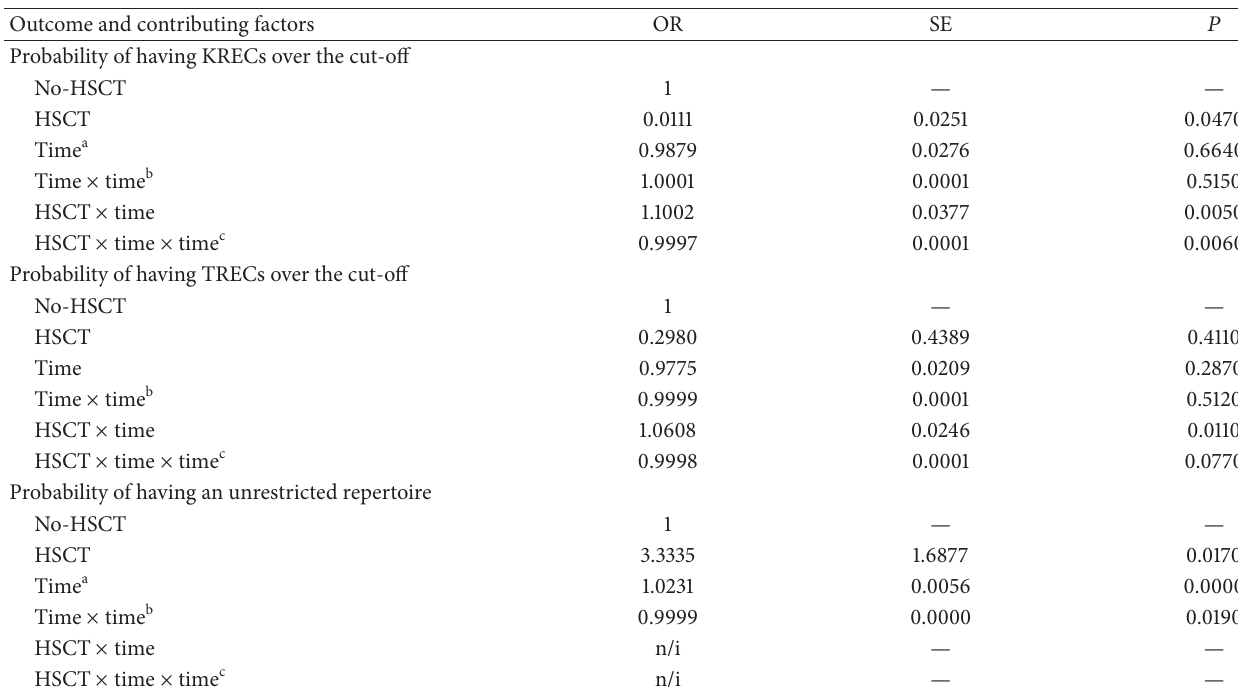
Table 3: Multivariable logistic models investigating differences in immune reconstitution between HSCT and no-HSCT patients. Outcome and contributing factors Probability of having KRECs over the cut-off